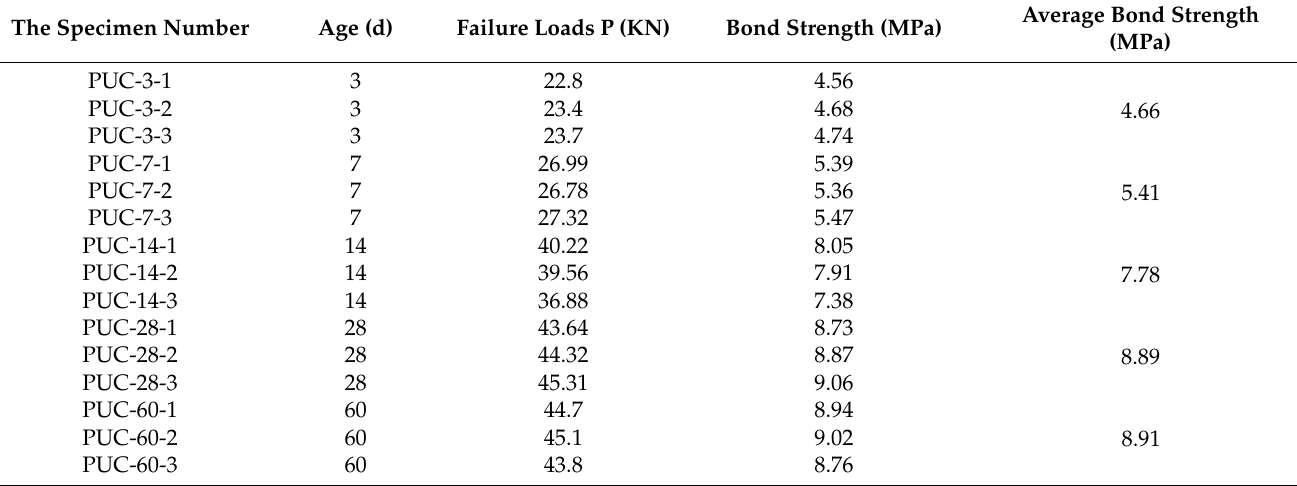
Table 8. Results of the bond strength of polyurethane concrete specimens and steel plates at different ages.